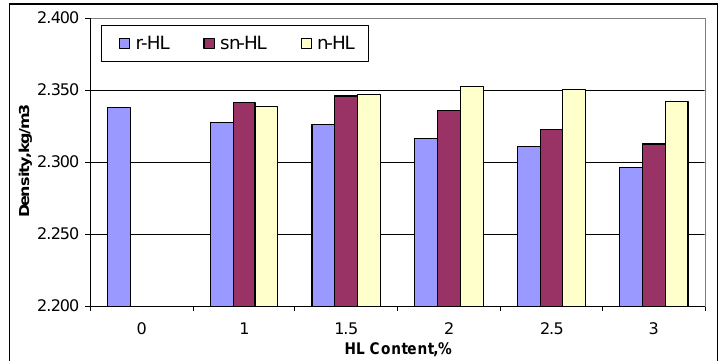
Figure 9. Comparison of density.